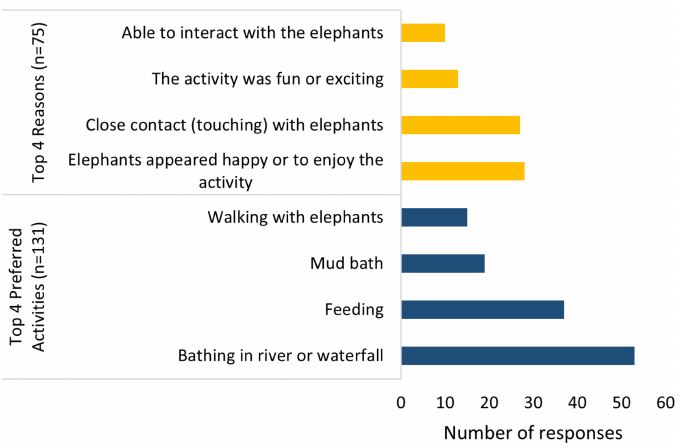
Figure 4. Respondents’ top four preferred activities ( bottom ) and the top four reasons respondents gave for choosing their preferred activity ( top ). 169 total activities and 123 total reasons stated (participants could give >1 activity and